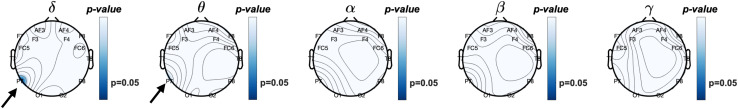
Topographical plot of Pearson correlations between resting EEG (Eyes-closed) relative frequency band power and mean reaction times during working memory task. Significant negative correlation was observed at the P7 (left parieto-occipital site) at delta (δ) frequency band (p < 0.05) and approaching significant (p = 0.068) theta (θ) band power. In other words, increased δ and θ frequencies power observed in the left posterior brain region is correlated with faster reaction times. Reaction times did not correlate with higher frequency band power, i.e., α, β, nor γ.